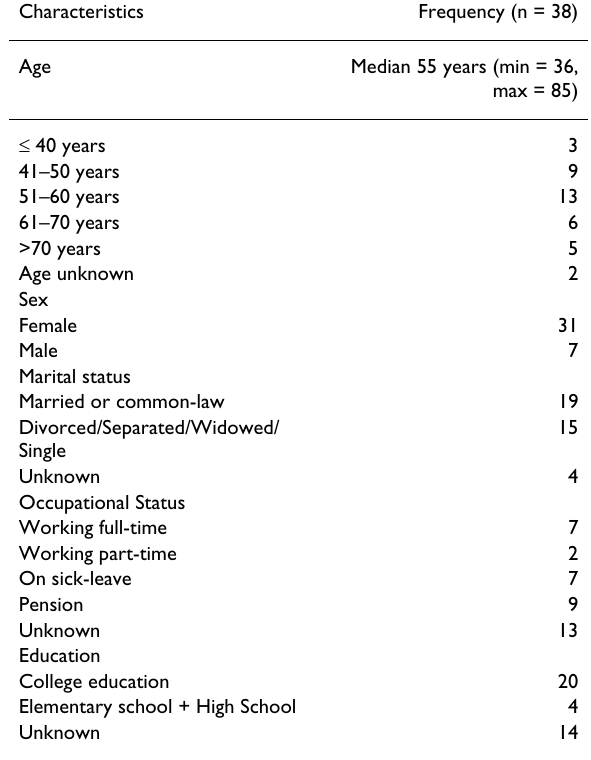
Table 1: Participant